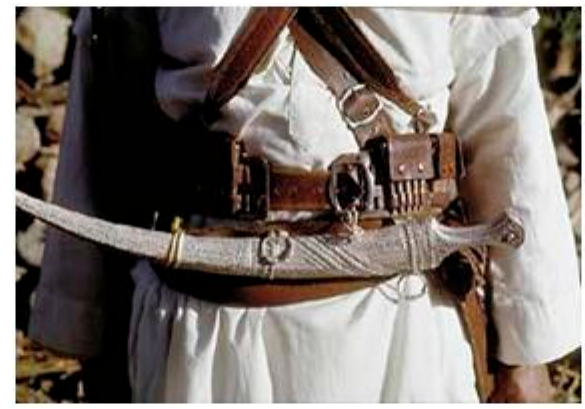
Figure 2. “The Sabiki Jambiyya ” (Blalock